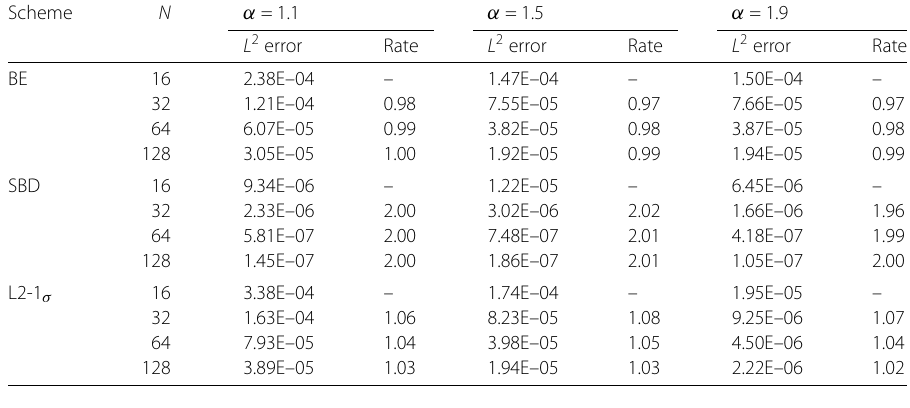
Table 7 The L 2 norm errors in time for case (e) in Example 6.2 with h = 1/10 Scheme